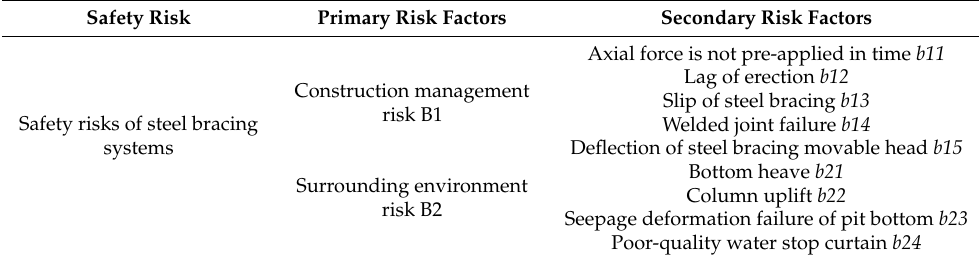
Table 2. List of safety risks of steel bracing